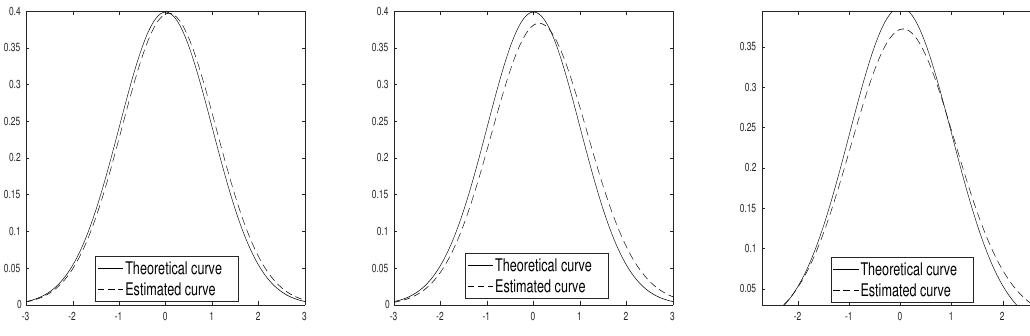
Figure 6: n = 200 and CR ≈ 46% for ( ρ 1 , ρ 2 ) = (0.1, 0.1), (0.2, 0.5) and (0.3, 0.8)